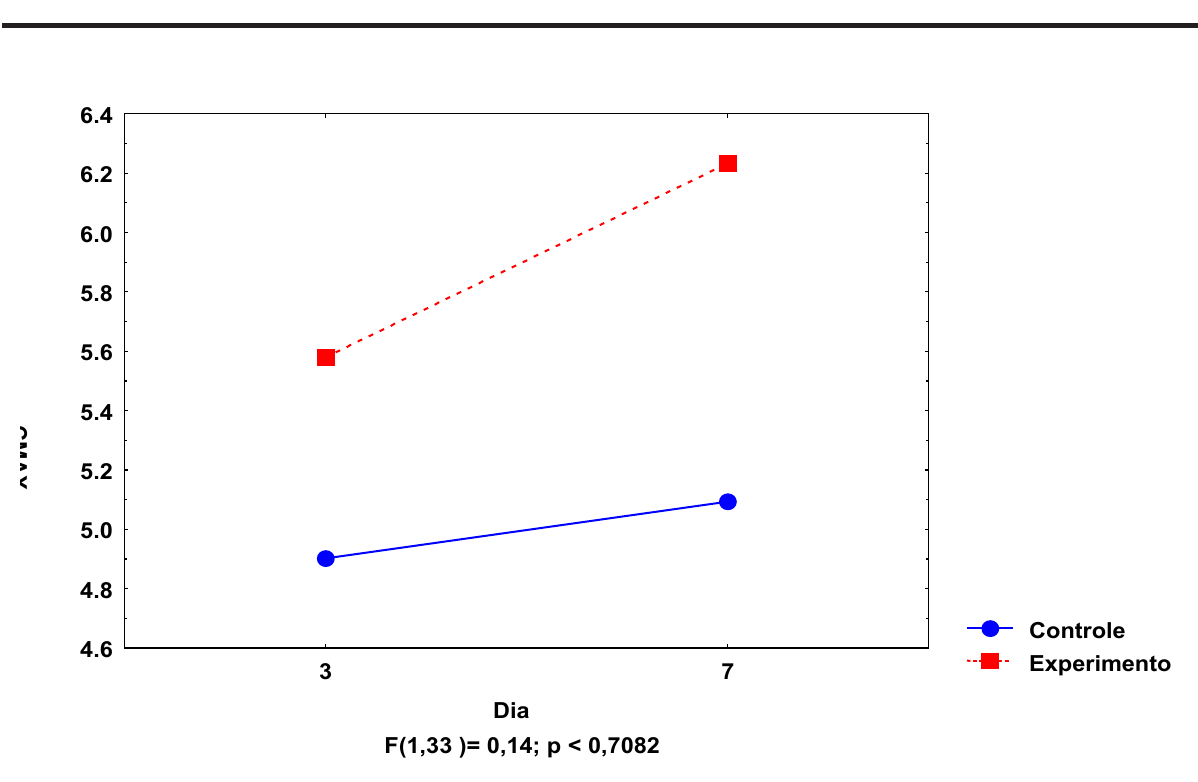
FIGURA 7 – Teste de Anova (análise de variância) para os grupos controle e experimento entre si em relação à carga máxima no terceiro e sétimo dia. LEGENDA: Cmax = carga máxima; F = valor do teste da ANOVA para interação; p = nível de